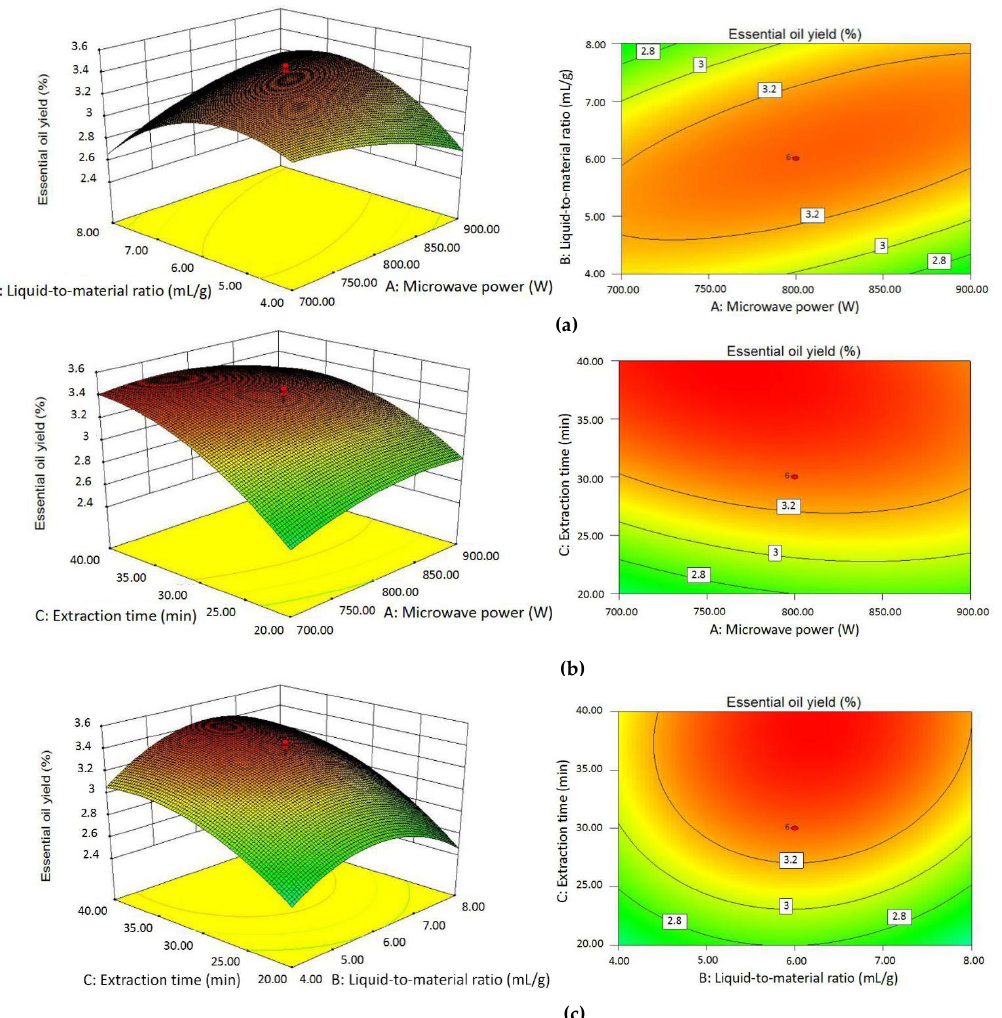
Figure 2. The three-dimensional response surfaces and contour plots of fresh leaf essential oil yield affected by microwave power and the liquid-to-material ratio ( a ); microwave power and extraction time ( b ); and liquid-to-material ratio and extraction time ( c ).